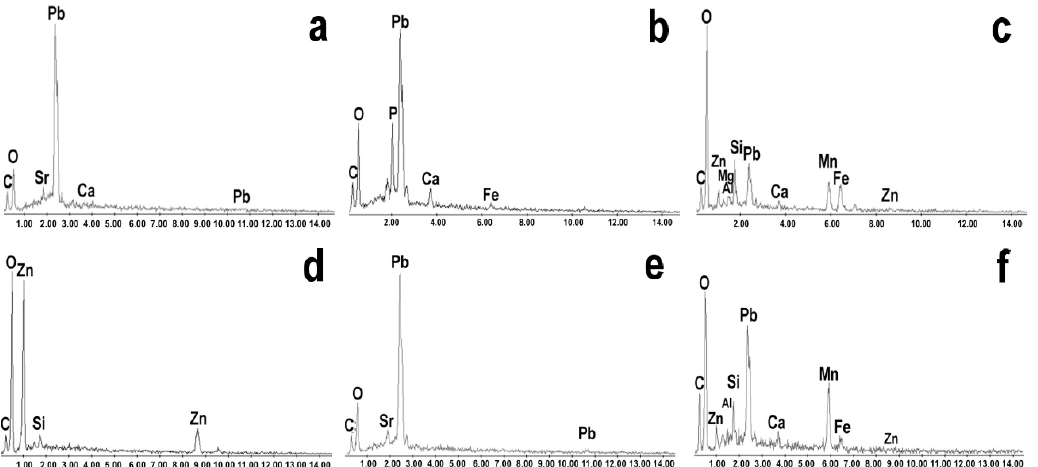
Figure 3. EDS spectra of minerals. Site of archaeological investigation in medieval smelter areas (LO): ( a ) Pb-oxide ( b ) Pb-phosphate ( c ) polymineral aggregates; Pb- and Zn-carbonate, Mn- and Fe-oxide, aluminosilicate. Site of the Zn-Pb ore washing process, area Kawa (KA): ( d ) Zn-carbonate, ( e ) Pb-carbonate, ( f ) aggregated Pb- and Zn-carbonate, Mn- and Fe-oxide, aluminosilicates.